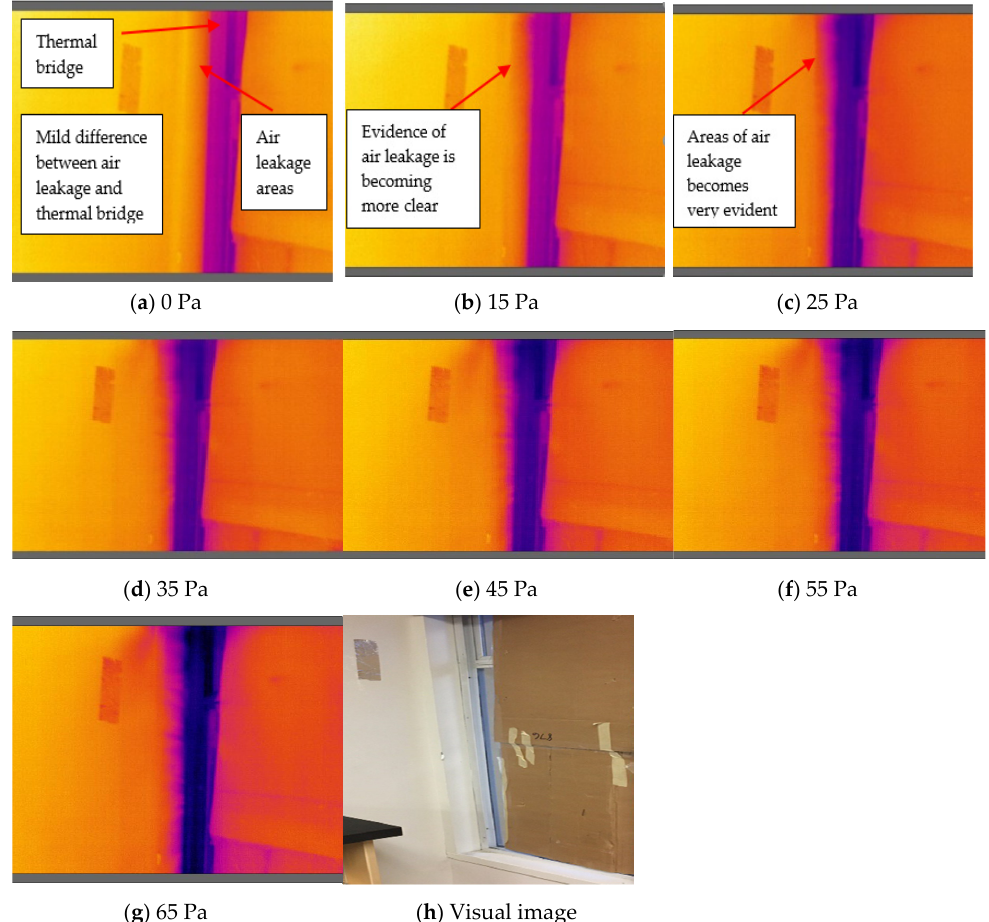
Figure 2. Window frame thermal images (temperature difference in degrees Celsius) taken from the interior in a depressurized room, at varying ∆P : ( a ) 0 Pa; ( b ) 15 Pa; ( c ) 25 Pa; ( d ) 35 Pa; ( e ) 45 Pa; ( f ) 55 Pa; ( g ) 65 Pa; ( h ) Visual image.